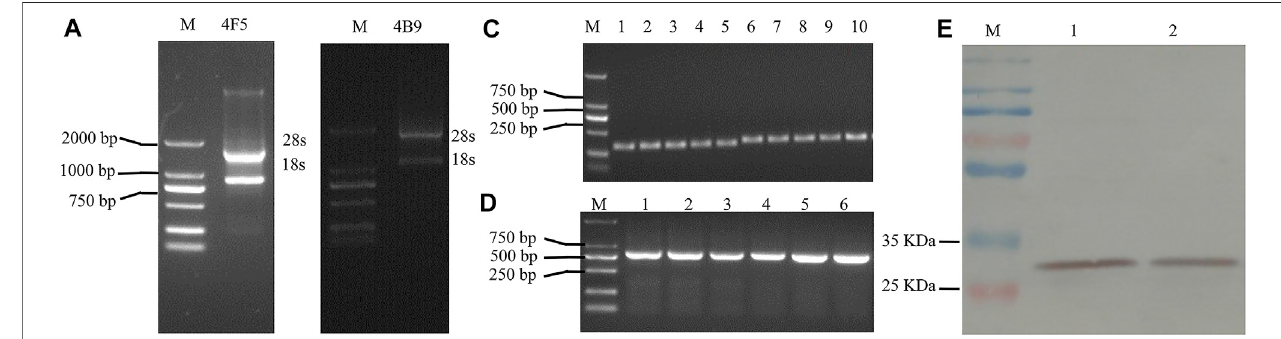
FIGURE 1 | Agarose gel electrophoresis analysis and western blot analysis of 4F5 and 4B9 scFv. (A) : Agarose gel electrophoresis of 4F5 total RNA, M indicates DNA2000plusmarker. (B) :Agarosegelelectrophoresis of4B9totalRNA,MndicatesDNA2000plusmarker. (C) :AgarosegelelectrophoresisofVHandVLof4F5and 4B9, 1 – 3 indicates 4F5 VH, 4 – 5 indicates 4B9 VH, 6 – 8 indicates 4F5 VL, 9 – 10 indicates 4B9 VL. (D) : Agarose gel electrophoresis of 4F5 scFv and 4B9 scFv, 1 – 3 indicates 4F5 scFv, 4 – 6 l indicates 4B9 scFv. (E) : The western blot analysis of 4F5 scFv and 4B9 scFv. M: marker, 1 indicates 4F5 scFv, 2 indicates 4B9